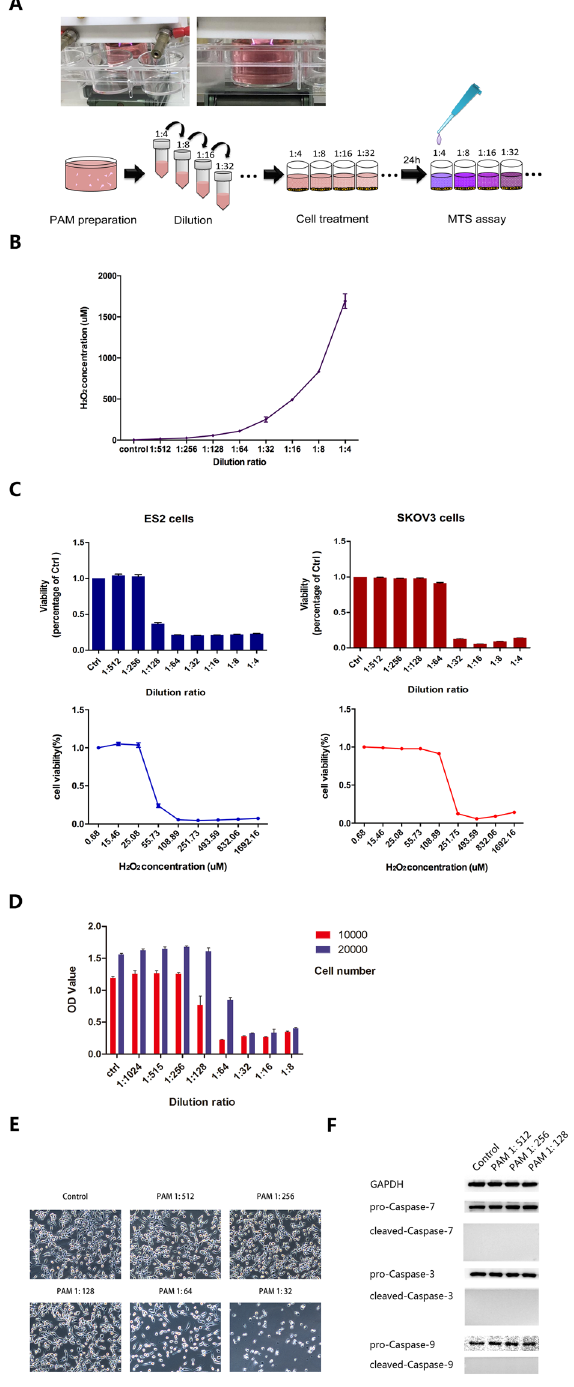
Figure 1. Plasma-activated medium (PAM) inhibits the viability of ovarian cancer cells, depending on the cell type, cell number and PAM dilution ratio. ( A ) The generation system of PAM and the experimental workflow. ( B ) H 2 O 2 concentrations in each diluted PAM were measured using Amplex red reagent. ( C ) The sensitivities of ES2 and SKOV3 cells to PAM were analysed according to the LD 50 value. ( D ) Cell viability using the MTS assay at different cell numbers and the corresponding PAM dilution ratio. ( E ) Morphological changes in ES2 cells after PAM treatment at each dilution ratio. A safe range of PAM with weak cell toxicity is confirmed. ( F ) After treatment with PAM at the safe range of the dilution ratio for 24 h, ES2 cells were collected for analysis of cell apoptosis markers using western blotting. GAPDH is used as an internal reference. The original full-length blots are presented in Supplementary Figure 3. Data from the MTS assay and H 2 O 2 mesurement are presented as mean ± SD. Three replicates were